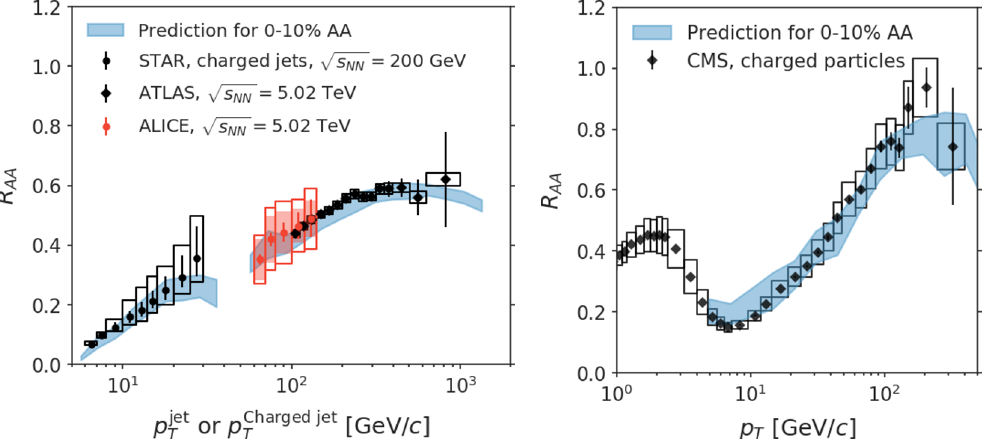
Figure 5 . Validation of the representative parameter sets by performing full model calculations using the nine sets of parameters listed in table 1. The bands correspond to the envelop of the nine